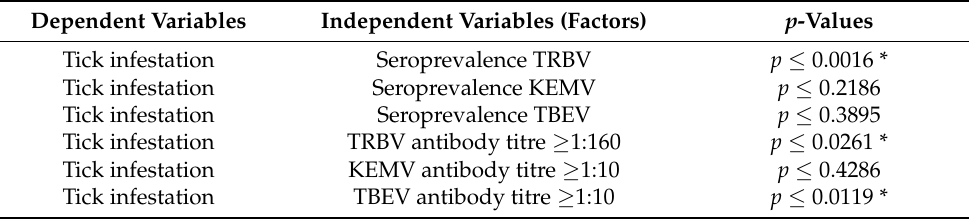
Table 6. Results of Fisher’s exact tests for determination of the difference between tick-infested and non-infested birds in seroprevalence and antibody